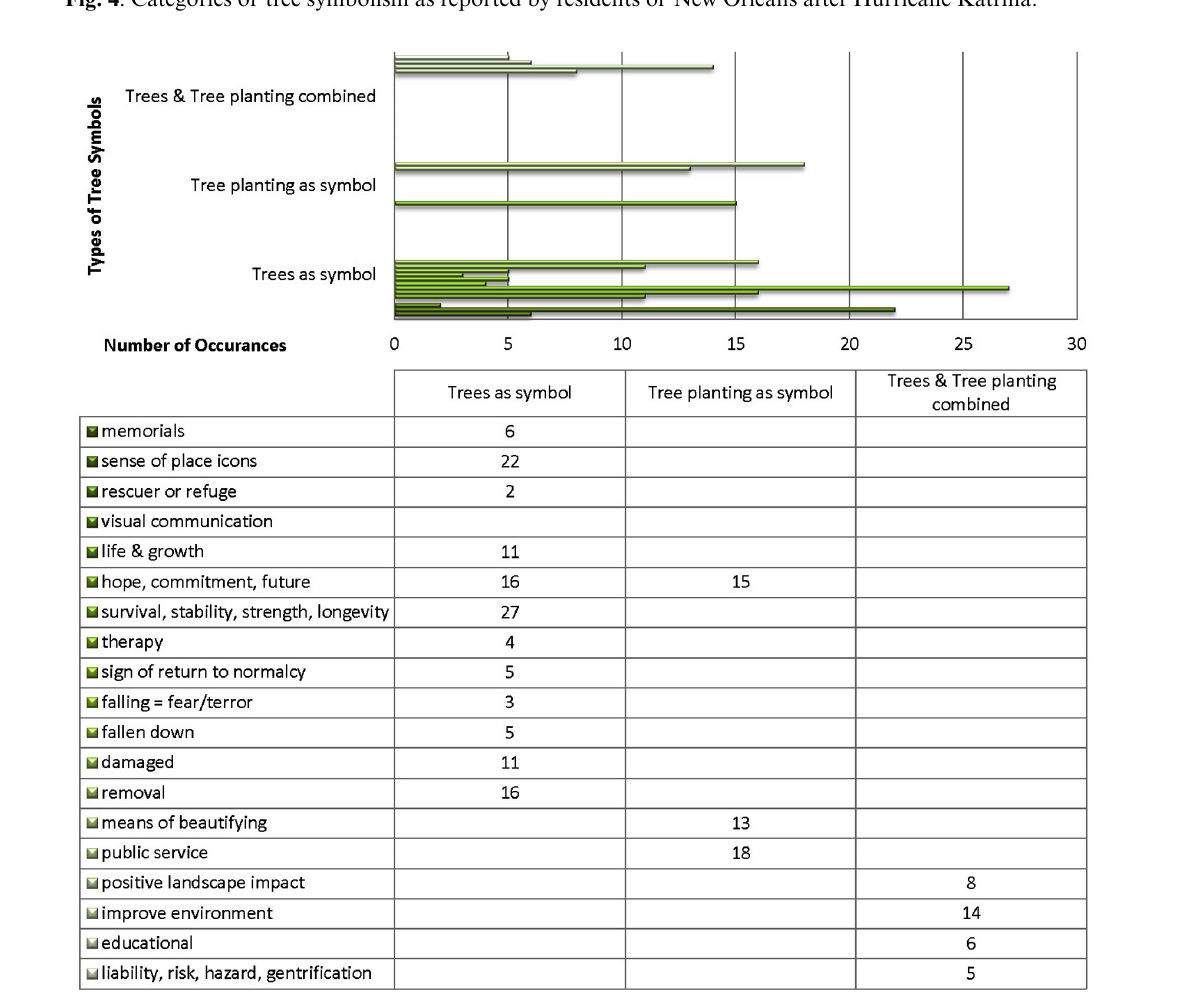
Fig. 4 . Categories of tree symbolism as reported by residents of New Orleans after Hurricane Katrina.